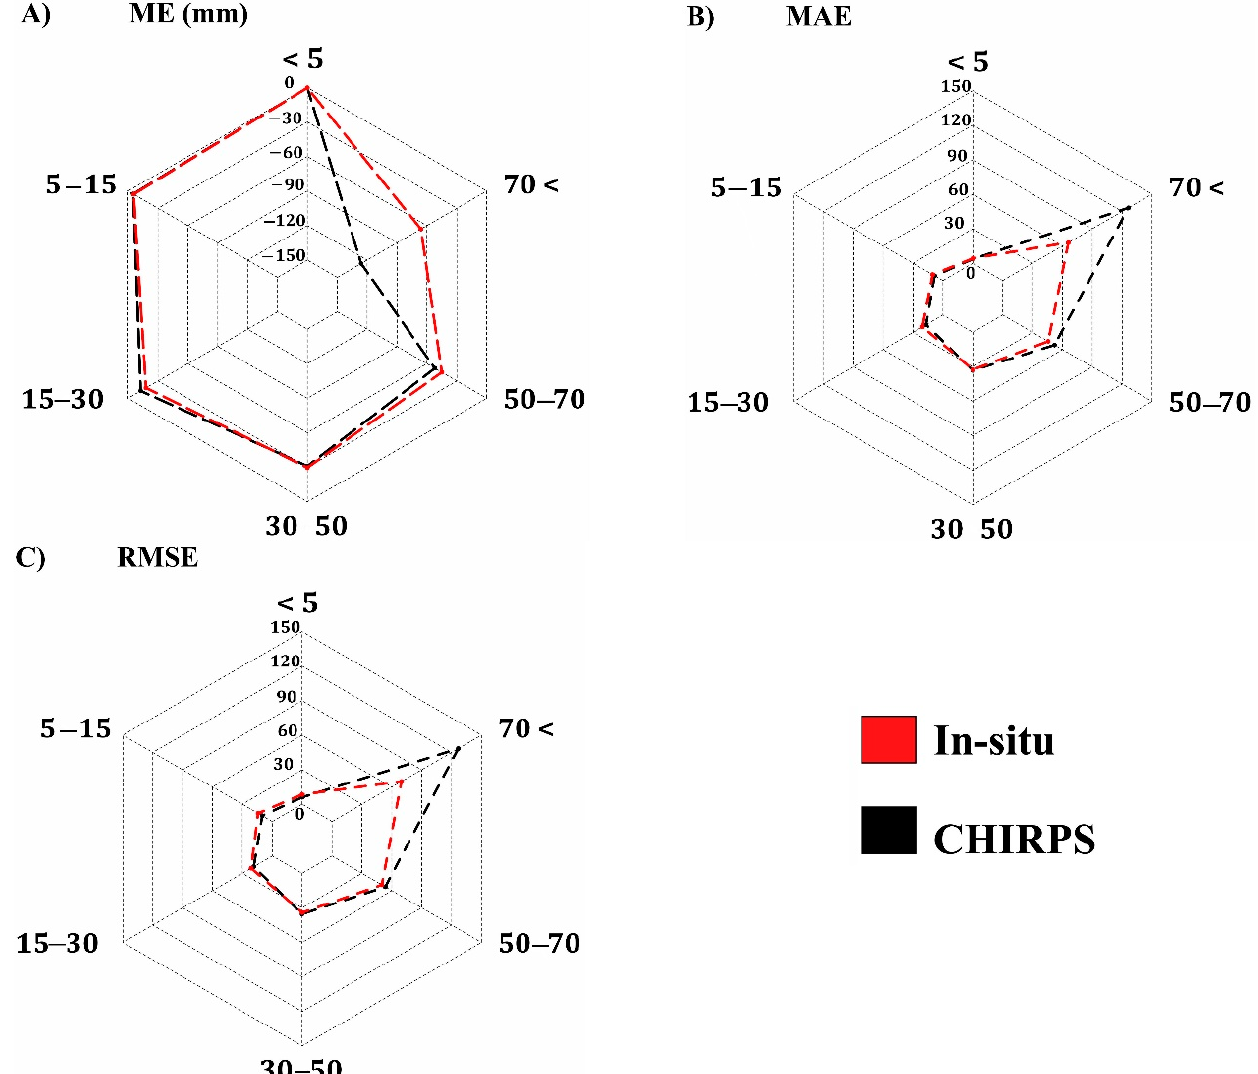
Figure 3. Accuracy statistics results of daily events based on the classi fi cation in Table 5. Table 5. Classi fi cation of precipitation events from all stations (12 stations) in the Barada Basin be- tween 2010 and 2020.